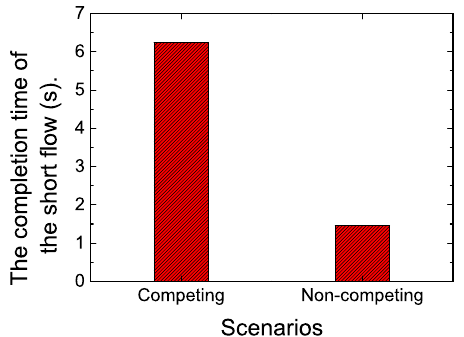
Figure 2. The flow completion time (FCT) of the short flow when it competes with a long flow with the size of 10 MB or not. The size of the short flow is 128